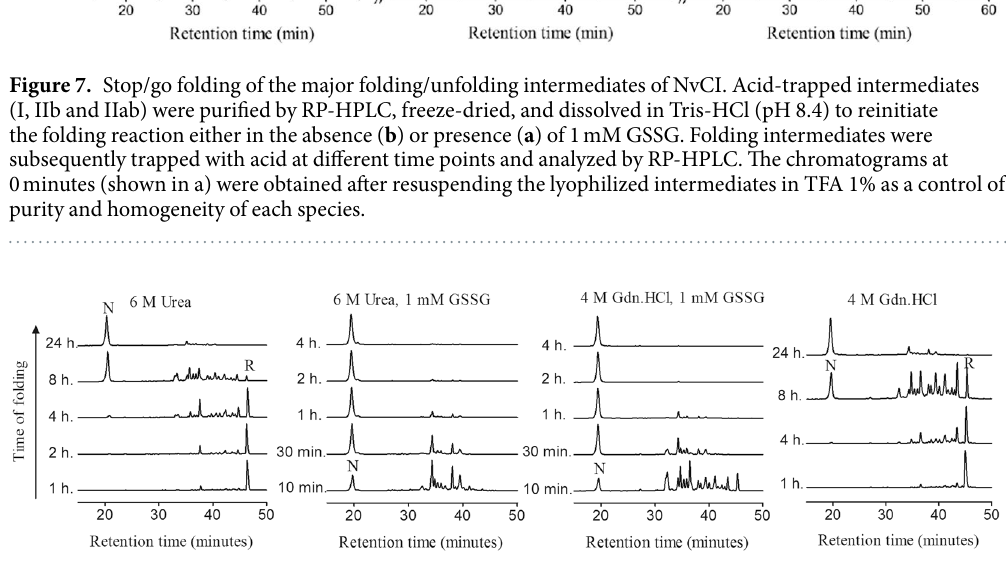
Figure 8. Oxidative folding of NvCI in the presence of high denaturing conditions. The fully reduced/unfolded protein was allowed to refold in Tris-HCl buffer (pH 8.4) in the presence of: 6.0 M urea; 1 mM GSSG in 6.0 M urea; 4.0 M Gdn.HCl and 1 mM GSSG in 4.0 M Gdn.HCl. Intermediates were acid-trapped at the noted times and analyzed by RP-HPLC. The elution positions of native (N) and reduced (R) NvCI are